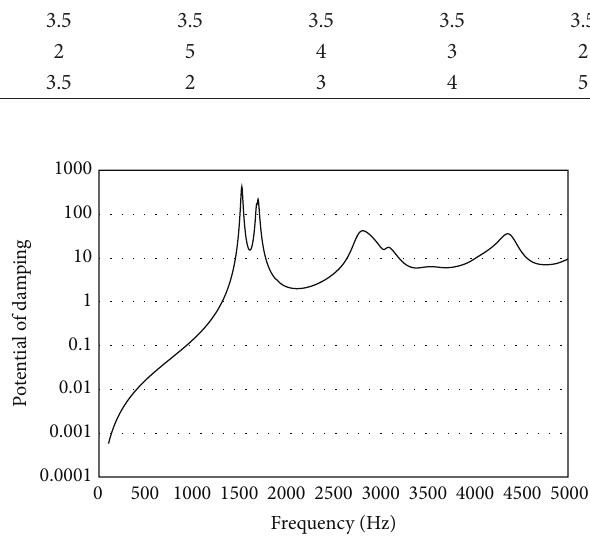
Figure 14: Damping potential of a damper designed for a particular